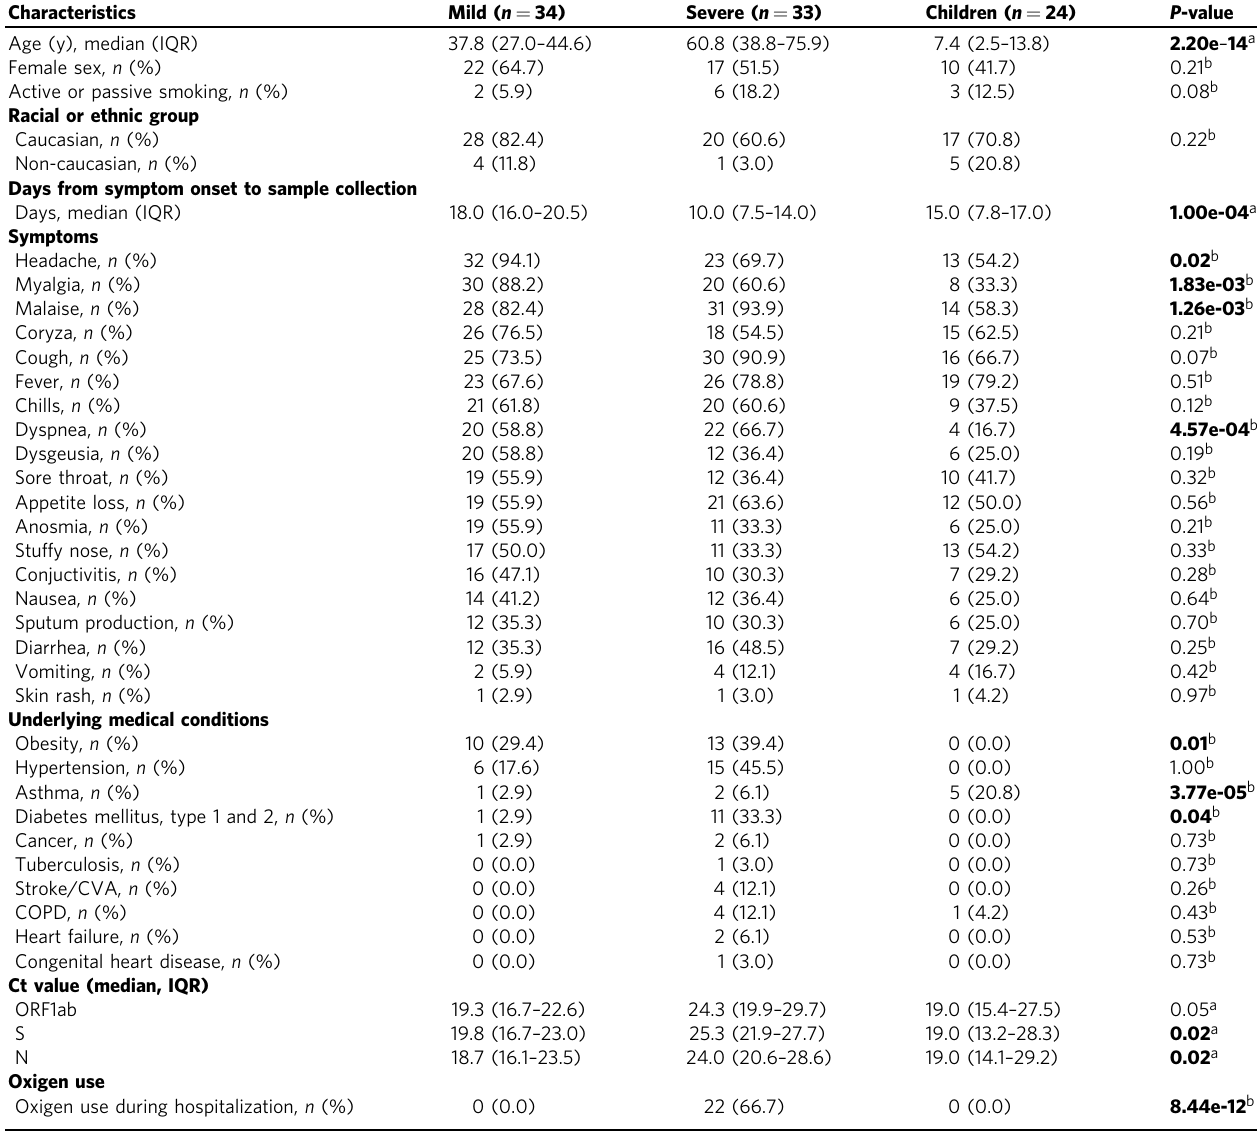
Table 1 Clinical characteristics of all patients in this study.